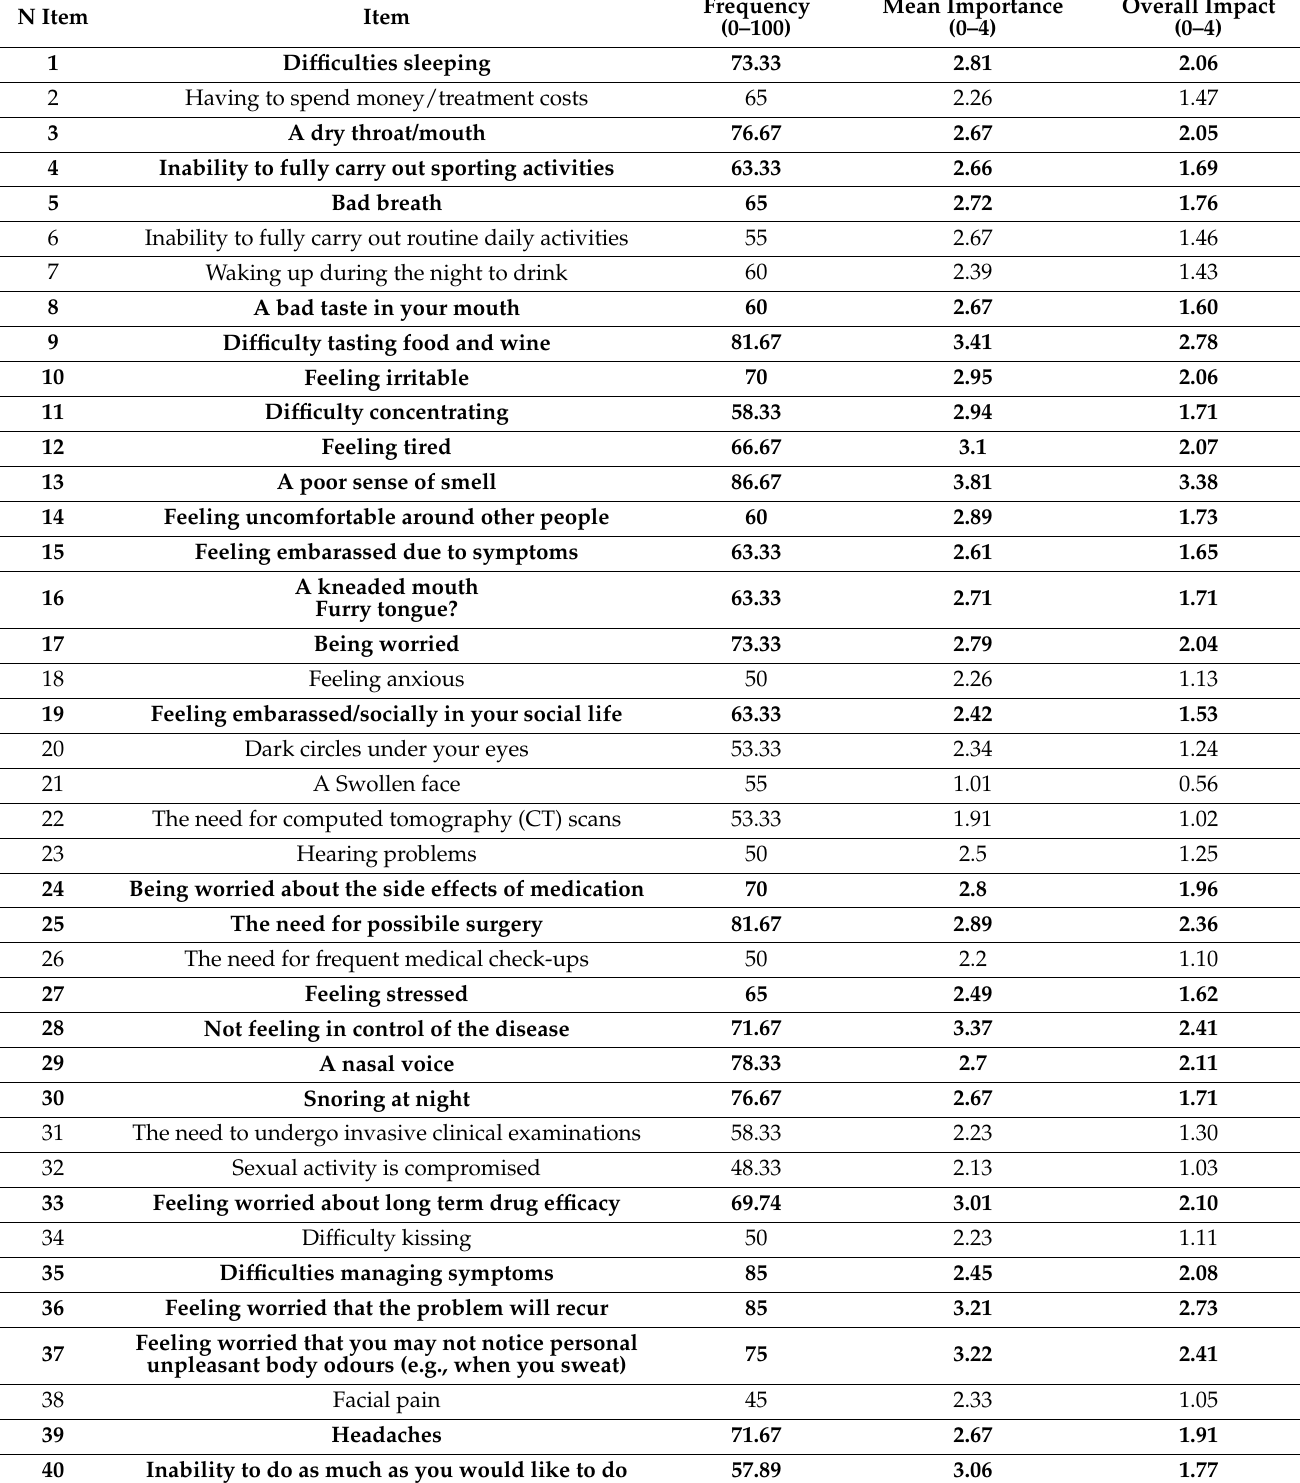
Table 1. Development process: results of item